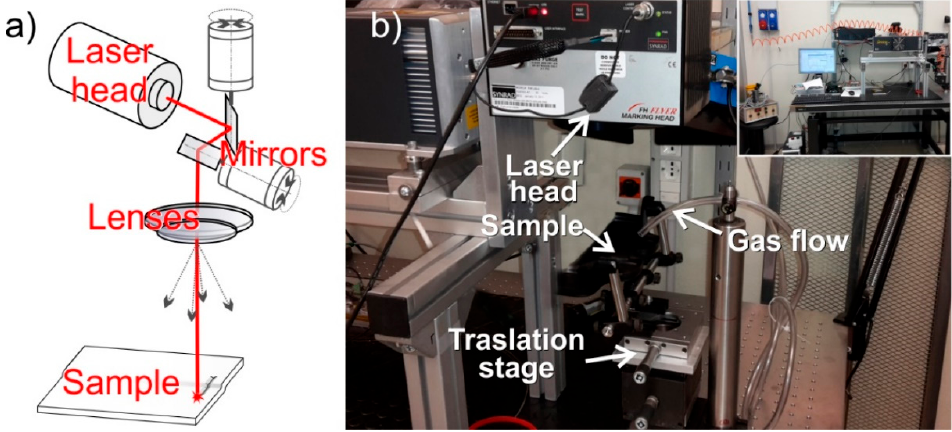
Figure 1. Schematic representation a) and picture b) of the laser printing